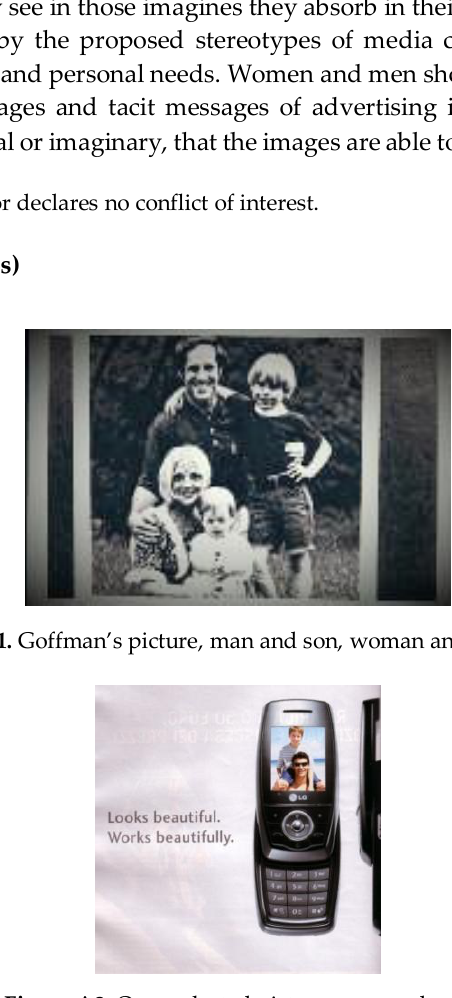
Figure A2. Own selected picture, man and